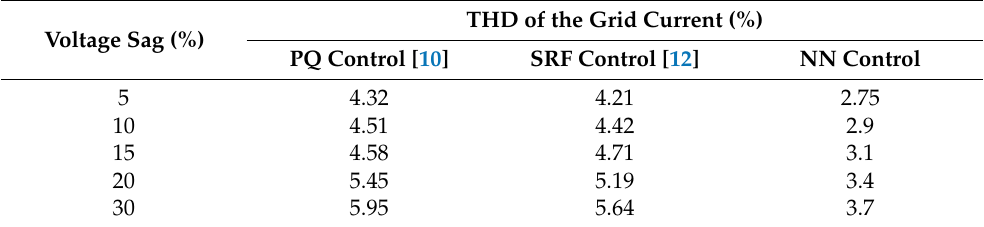
Table 2. Comparisons Grid current THD for NN controller with PQ and SRF control for various voltage sag conditions.